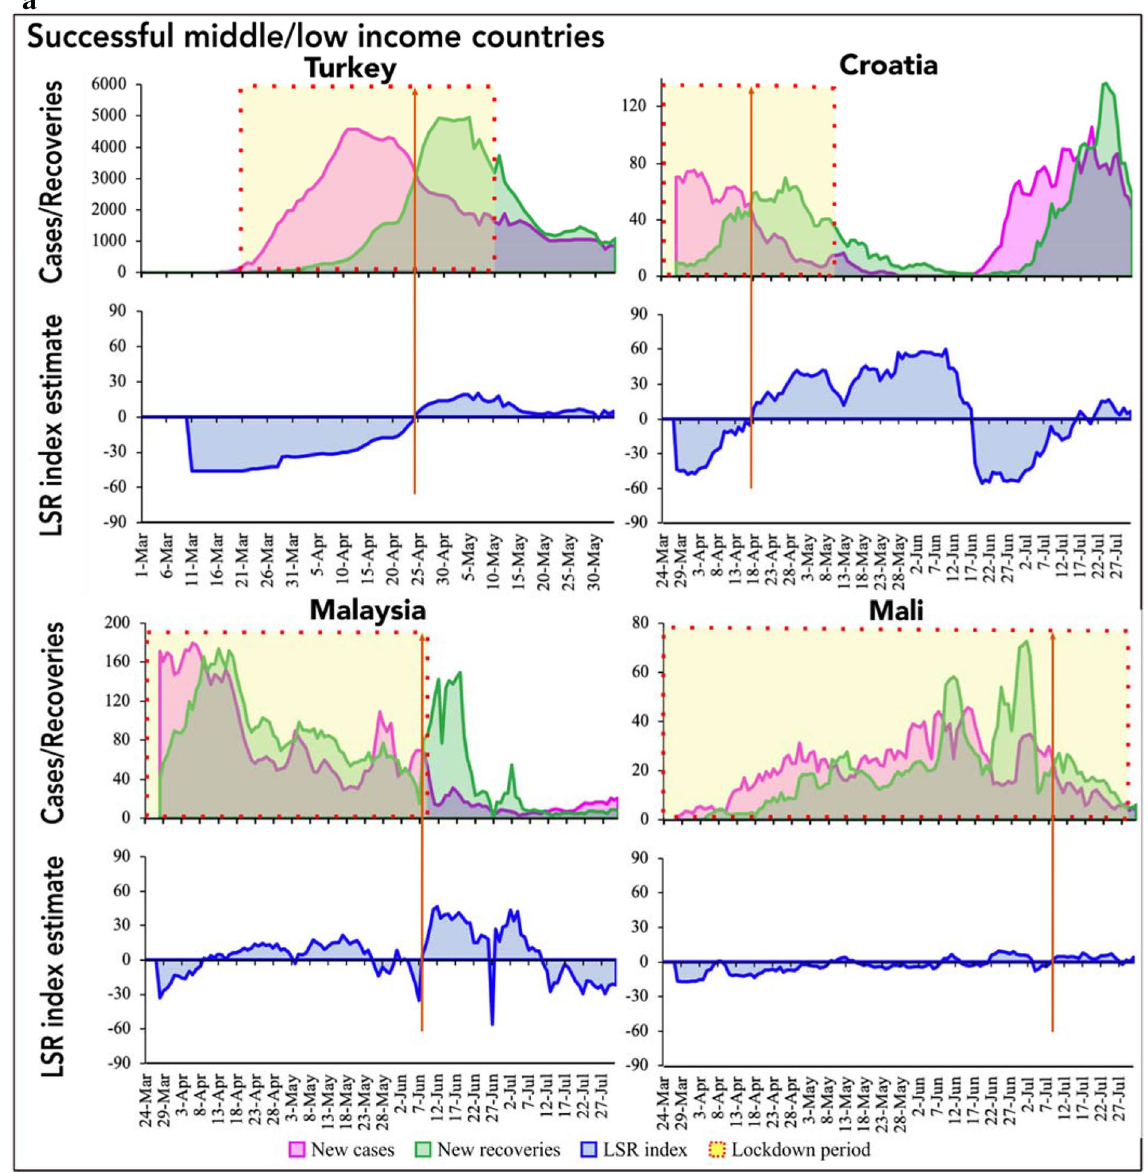
Figure 2. ( a ) Infection-recovery (top panel) and the corresponding LSR index (bottom panel) trajectories in the successful low/middle-income countries (Part a). ( b ) Infection-recovery (top panel) and the corresponding LSR index (bottom panel) trajectories in the successful low/middle-income countries (Part b). The brown vertical line indicates the day of infection-recovery